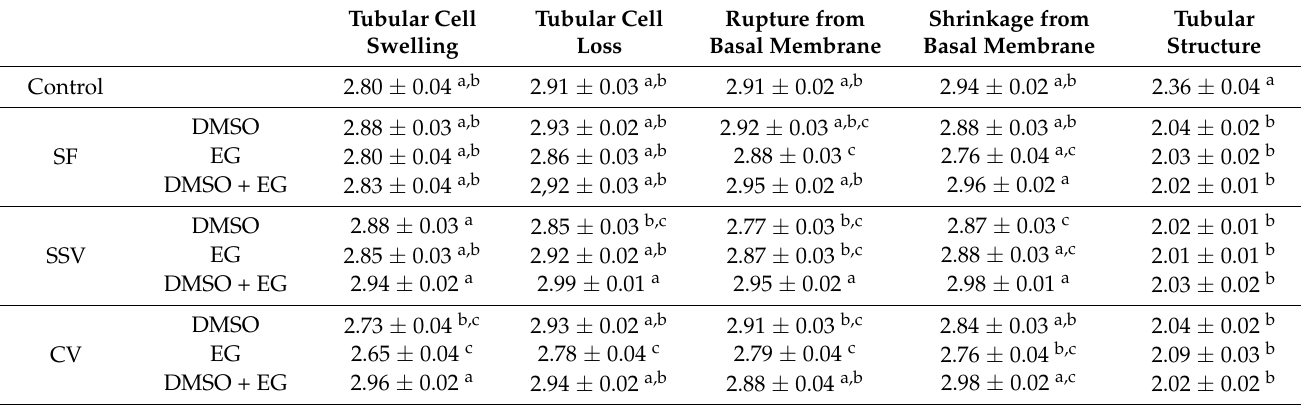
Table 2. Morphological evaluation (3, normal to 1, degenerated) of adult Dasyprocta leporina (n = 5 males) fresh (control) vs. cryopreserved testicular tissues using different cryopreservation techniques (slow freezing, SF; conventional vitrification, CV; solid surface vitrification, SSV) and